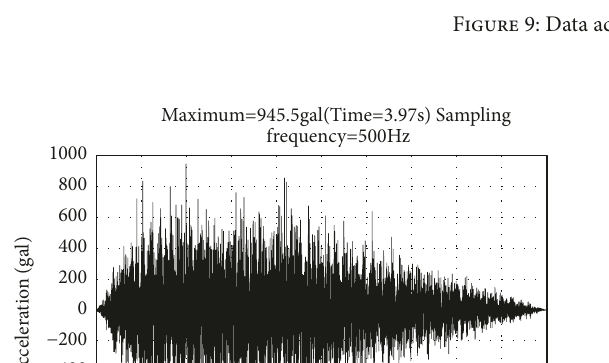
Figure 9: Data acquisition system.